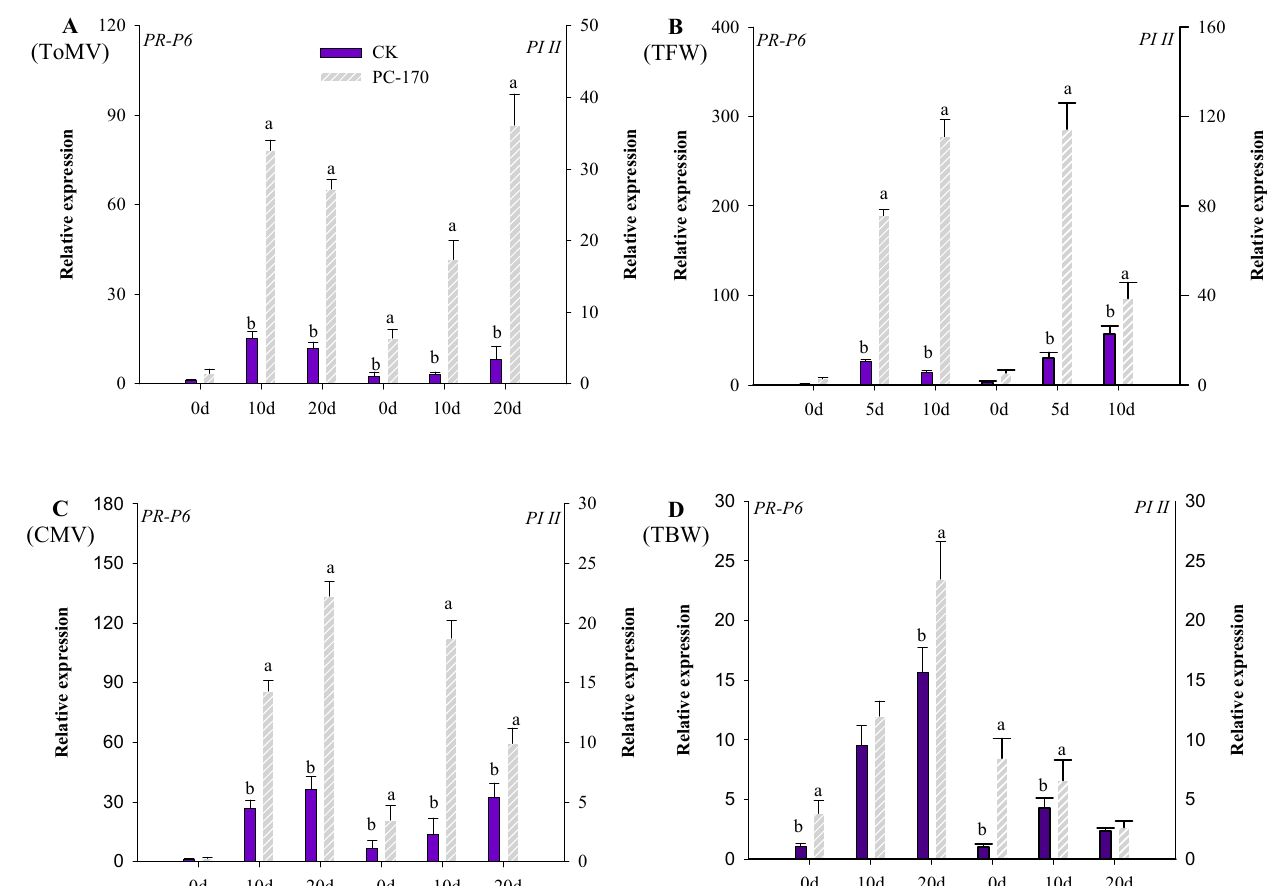
Figure 7. The expression of genes when PC-170 and pathogens interact in tomatoes. ( A ) The changes in the expression of the PR-P6 and PI II genes during pathogenesis after ToMV inoculation. ( B ) The changes in the expression of the PR-P6 and PI II genes during pathogenesis after TFW inoculation. ( C ) The changes in the expression of the PR-P6 and PI II genes during pathogenesis after CMV inoculation. ( D ) The changes in the expression of the PR-P6 and PI II genes during pathogenesis after TBW inoculation. Each value is the mean ± SE of three biological samples with three technical replicates each. Different letters indicate statistical differences between treatments ( p < 0.05).